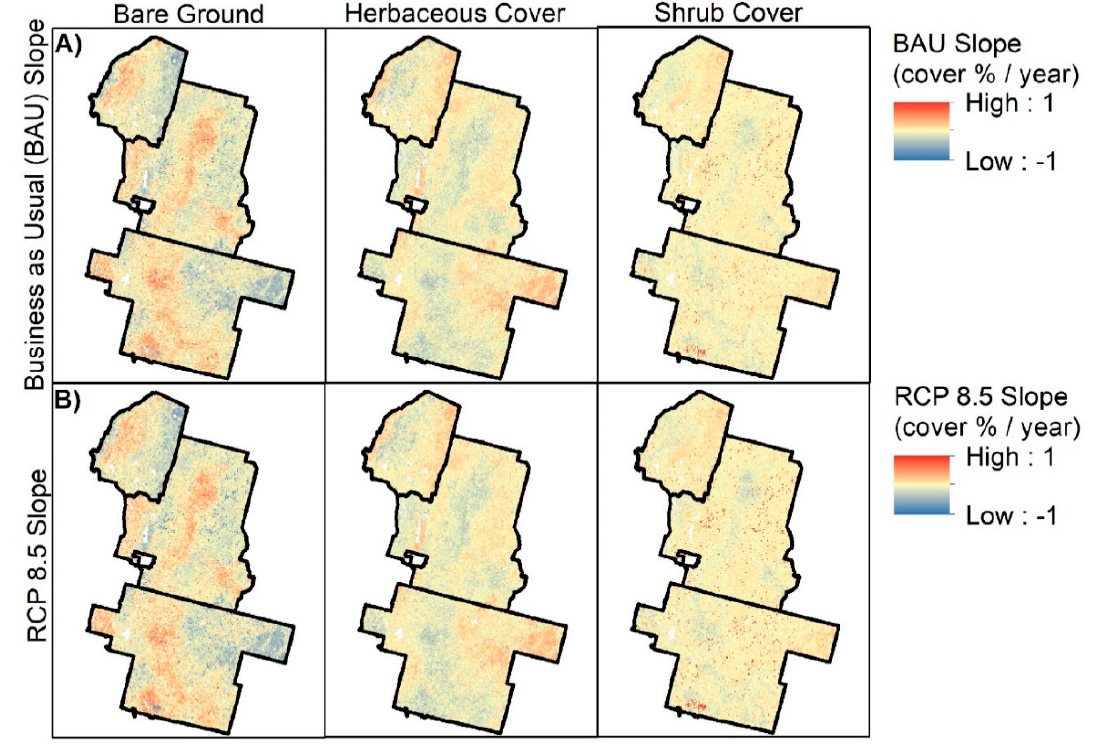
Figure 7. 2018–2050 temporal slope of rangeland fractional cover for ( A ) Business as Usual (BAU) and ( B ) RCP 8.5 scenarios, based on the mean across 30 Monte Carlo simulations. Table 4. Correlation ( r ) between fractional cover slope from 2018 to 2050 by scenario and elevation, 2018 cover, and 2018 to 2050 slope of other cover types. All correlations are significant ( p <